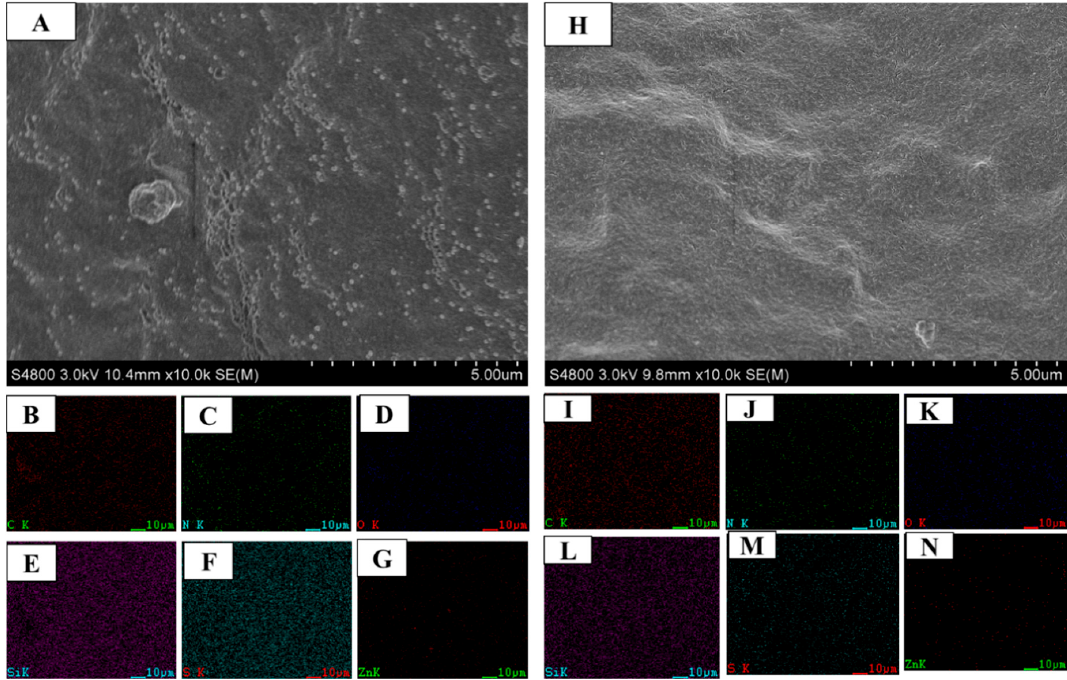
Figure 4. Scanning electron microscope (SEM) images of the vulcanizates ( φ = 0.177) containing Si69 ( A ) or Si69/[EMIM]OAc ( H ) and SEM-energy dispersive spectroscopy (SEM-EDS) maps of carbon ( B and I ), nitrogen ( C and J ), oxygen ( D and K ), silicon ( E and L ), sulphur ( F and M ), and zinc elements ( G and N ).